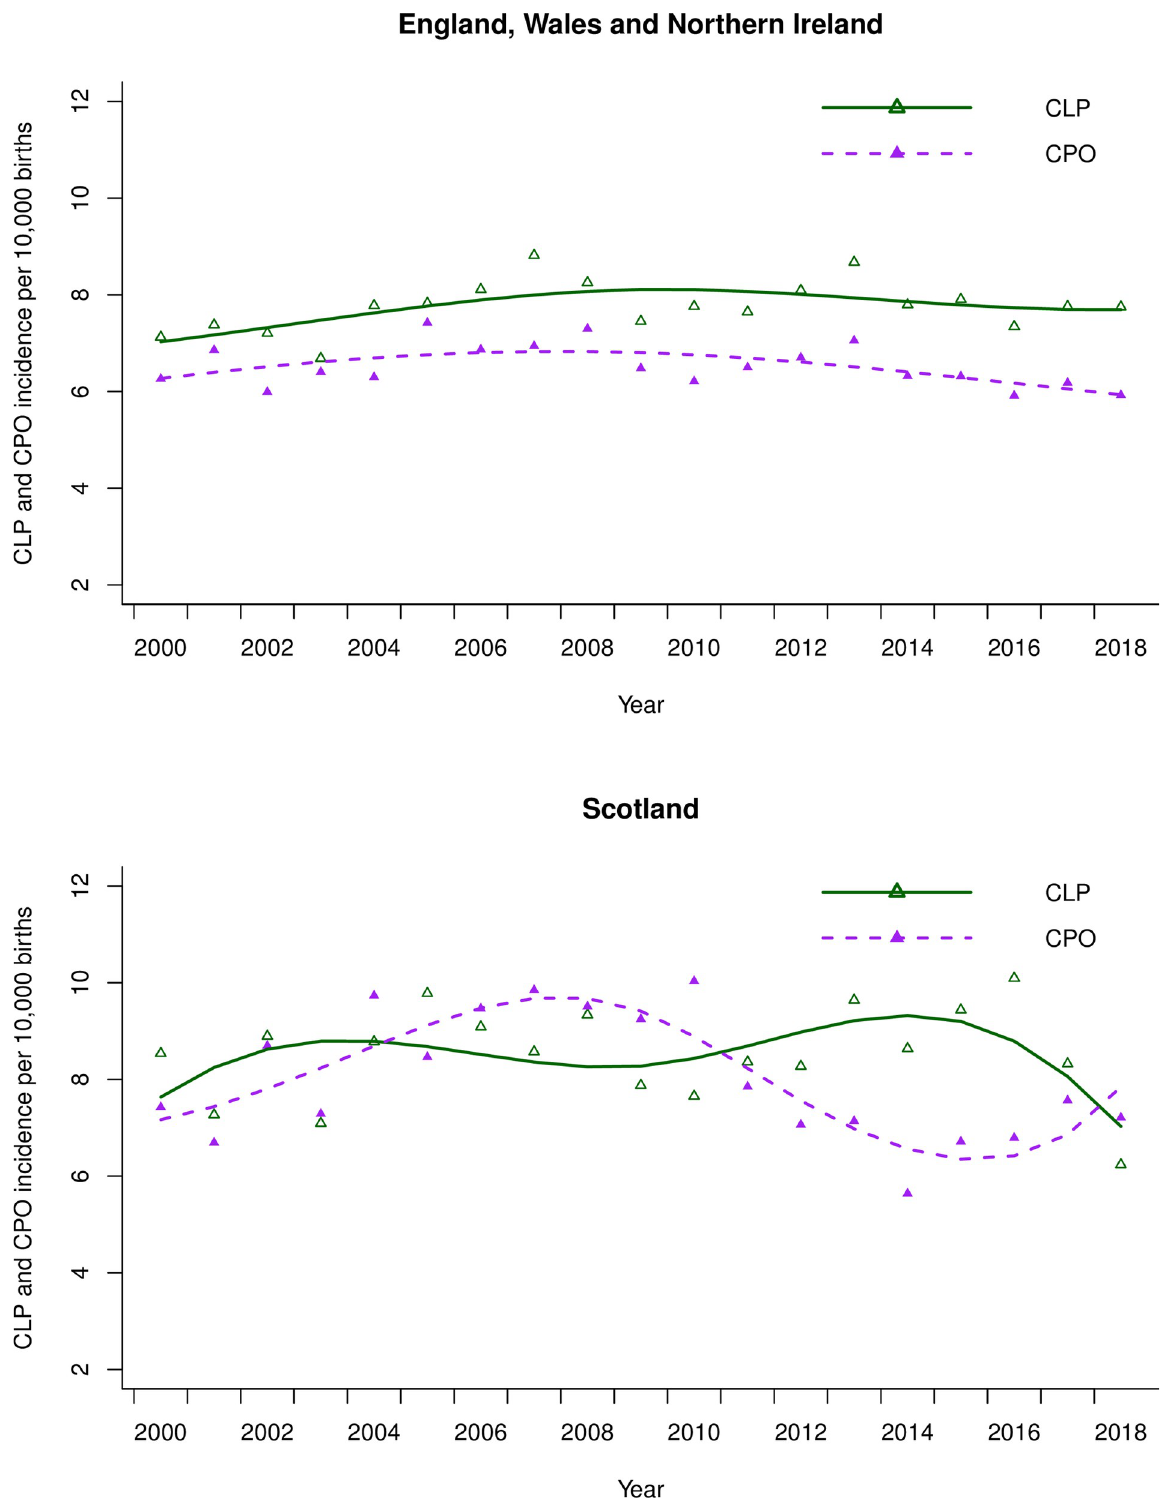
Fig 2. Quasi-Poisson regression line of the incidence of subtypes cleft lip +- palate (CLP) and cleft palate only (CPO) over time in England Wales and Northern Ireland and in Scotland with long-term trends modelled using cubic flexible spline functions. The scatter are the raw annual data